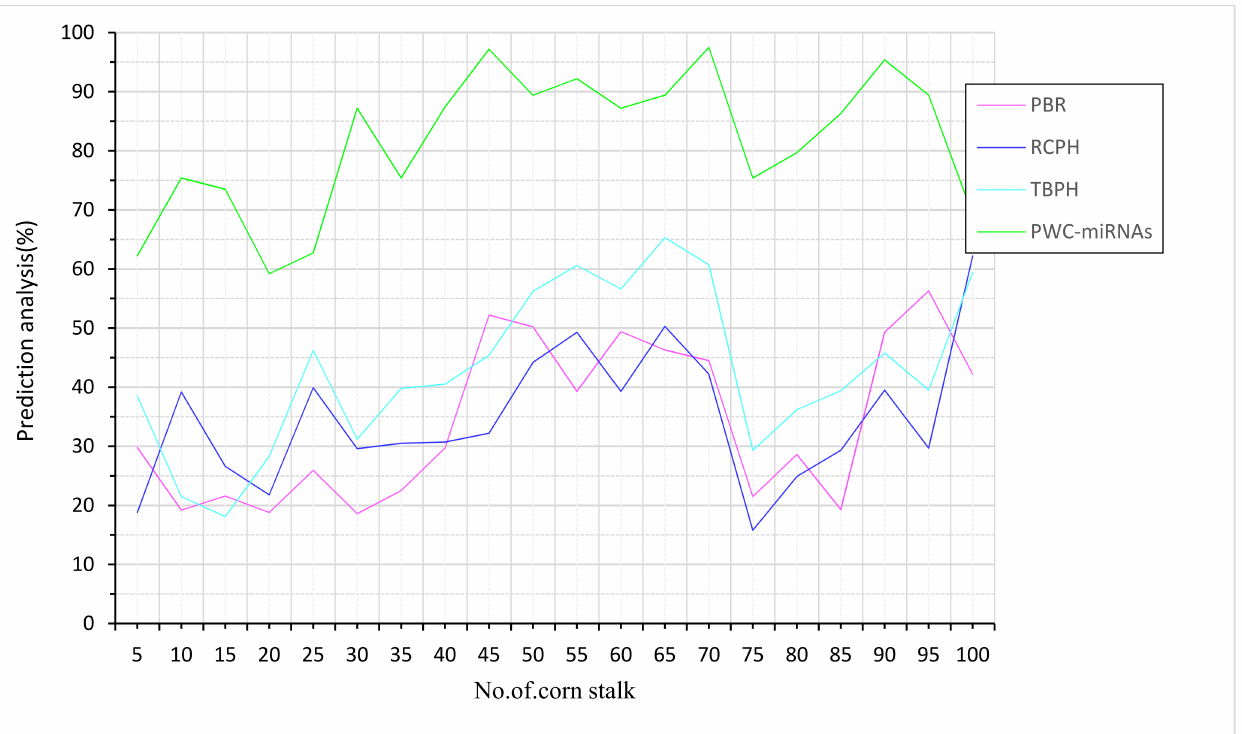
Figure 6. Corn-stalk prediction based on PWC-miRNAs. A corn-stalk’s skin is around millimeters thick, and the mass ratio and fiber content are about 80%. Based on PWC-miRNAs, the input taken for evaluation analysis for corn